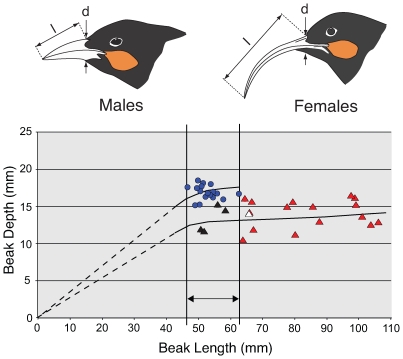
The relationships between beak length and depth for 17 male and 21 female Huia.Arrows indicate where measurements were made. Sex was determined using molecular methods. Blue circles represent males, red triangles indicate females, and black triangles represent the four DNA-sexed females that fall within the beak length range of males. Another DNA-sexed female, which was labelled ‘juvenile’, is indicated by a white triangle. Possible growth curves for males and females are shown by the black lines.